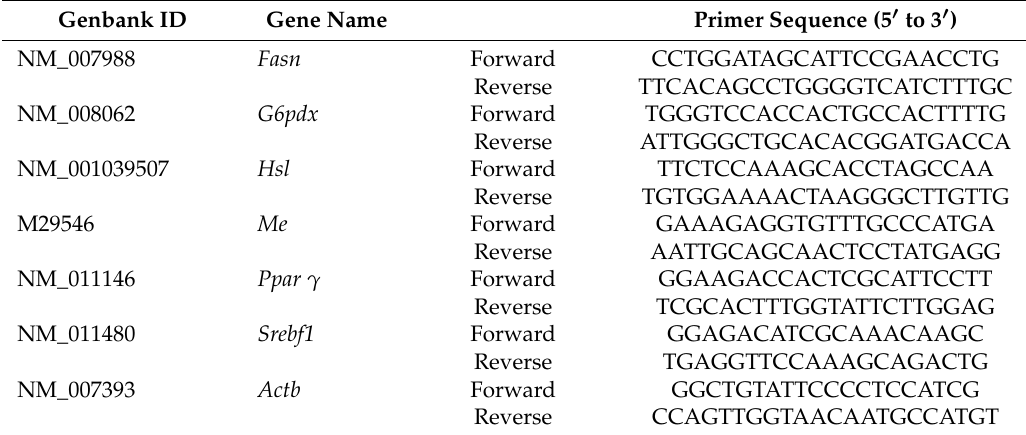
Table 2. Primer pairs used for the real time qRT-PCR analysis. Genbank